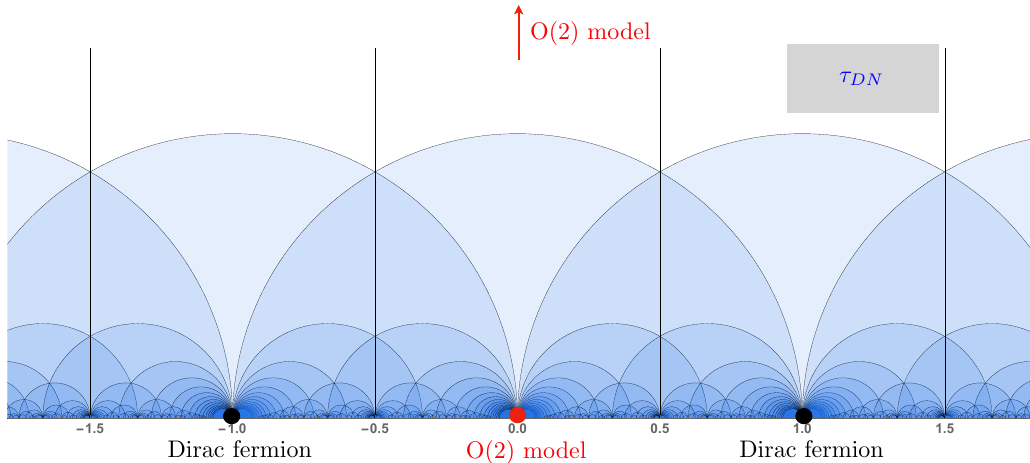
DN , i.e. in the duality frame in which at